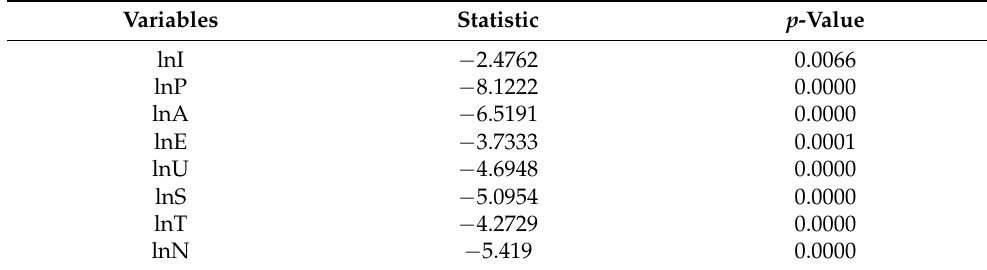
Table 4. The results of the LLC